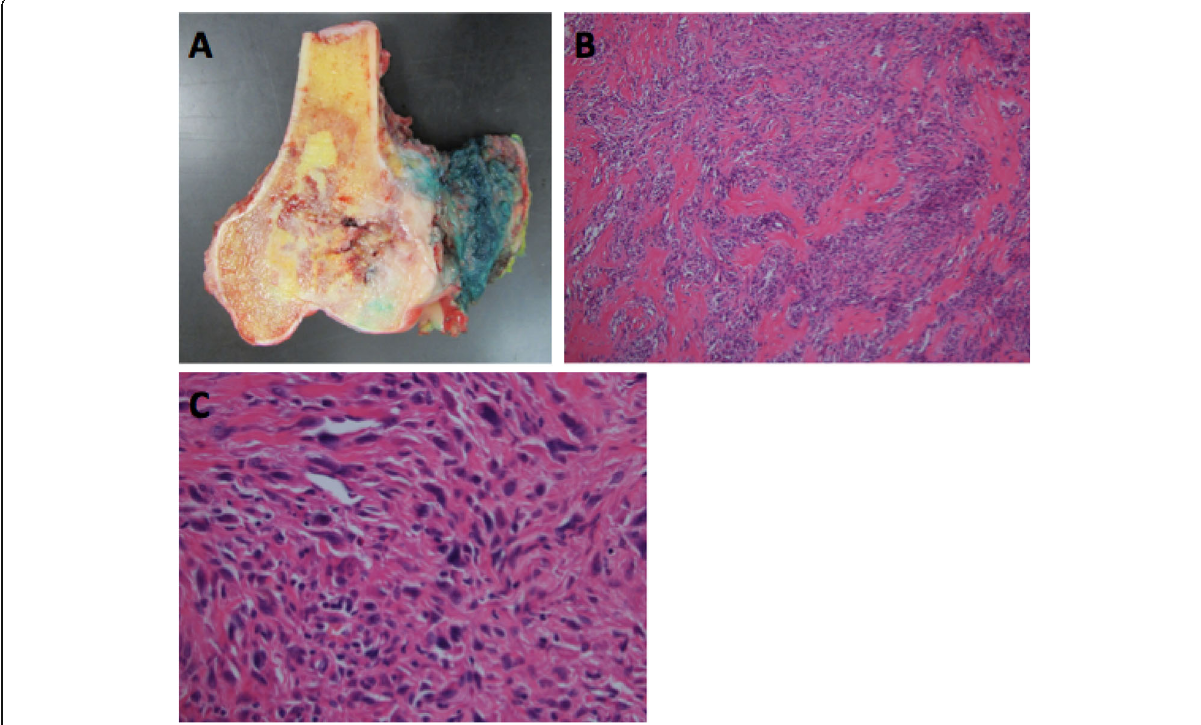
Fig. 6 a Clinical photograph of resected tumor b Photomicrograph demonstrating hypercellularity and fibrous stroma (× 10, H&E) c Photomicrograph demonstrating spindle shaped, pleomorphic nuclei (× 40,